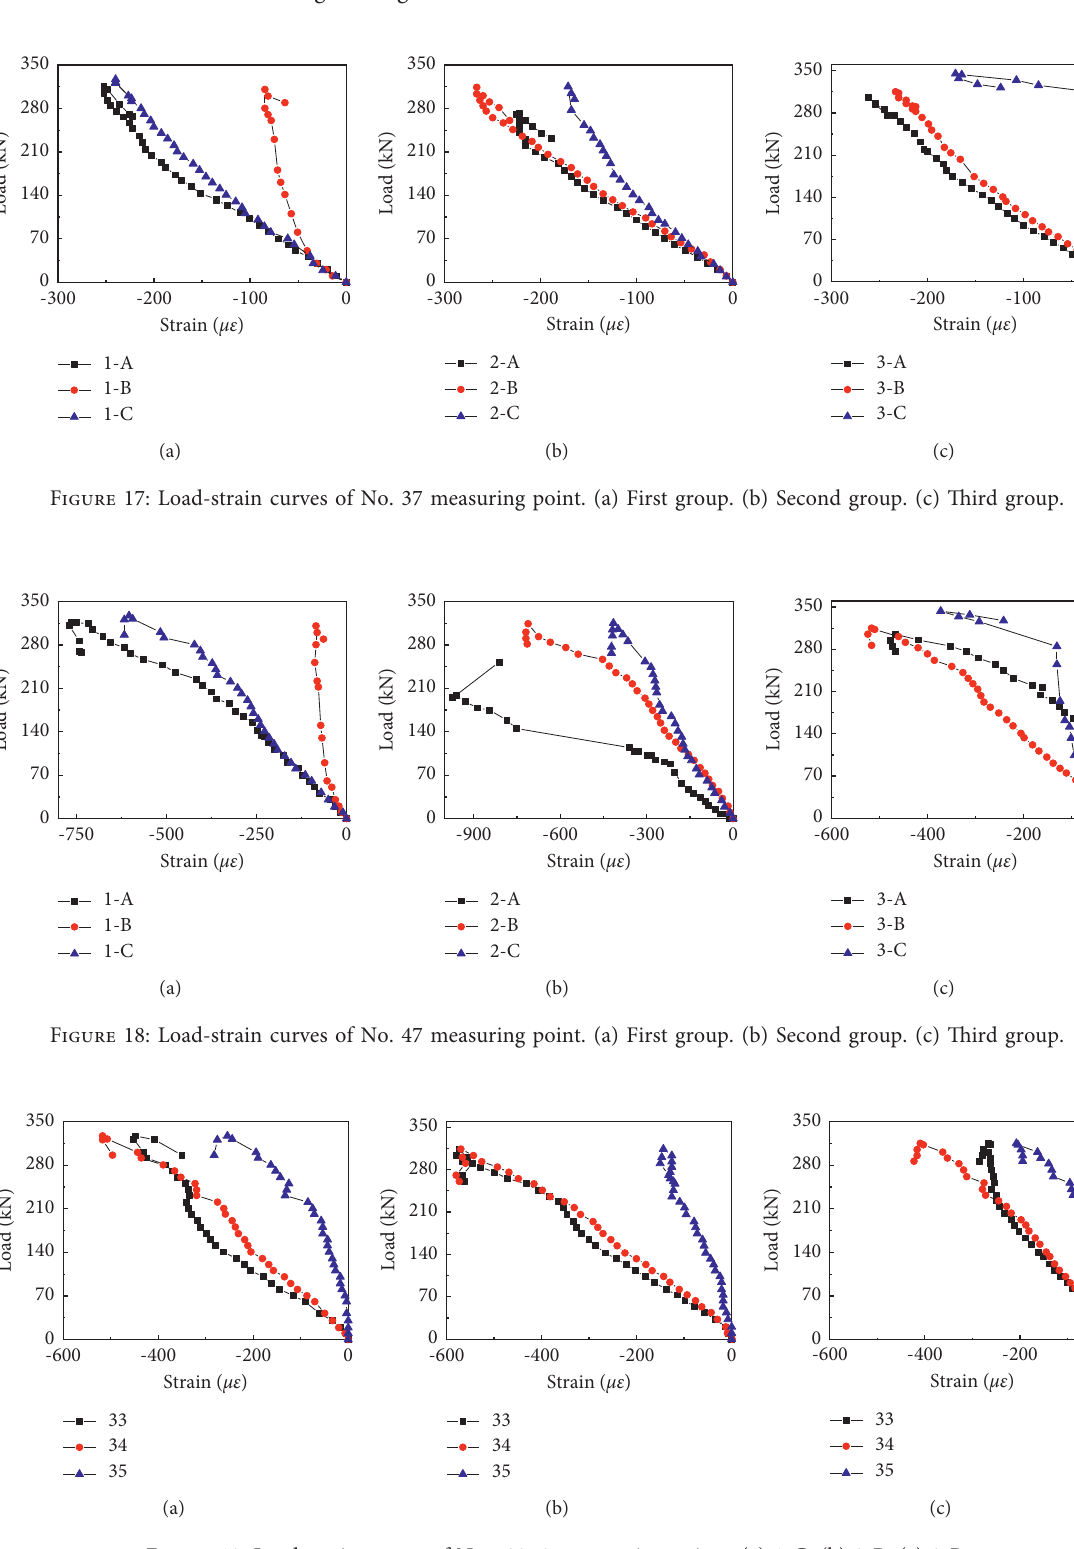
Figure 19: Load-strain curves of Nos. 33 ∼ 35 measuring points. (a) 1-C. (b) 2-B. (c)